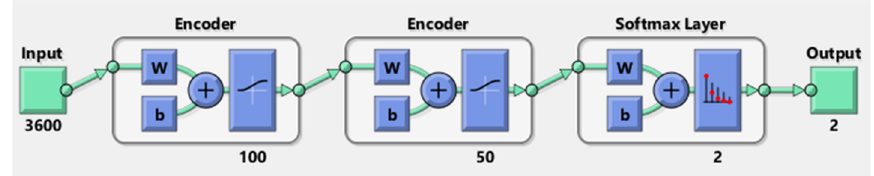
Figure 9. The stacked AE architecture.